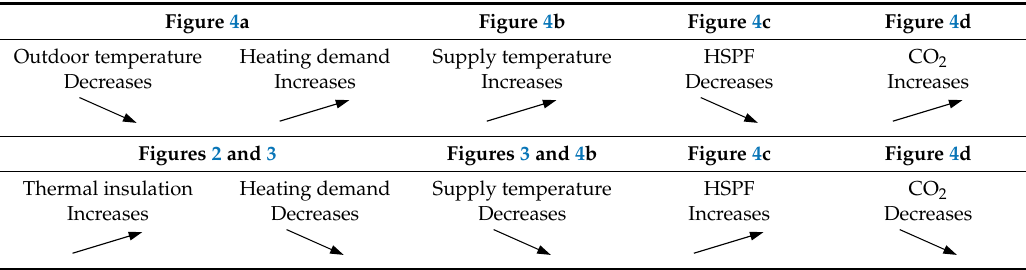
Decreases Increases Decreases